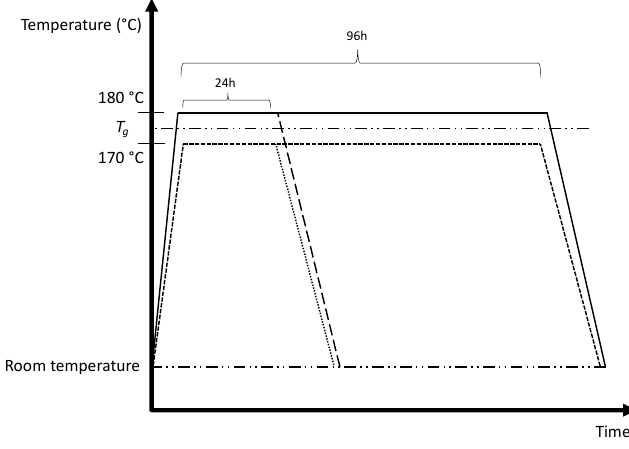
Figure 4. Temperature profiles for the annealing process.